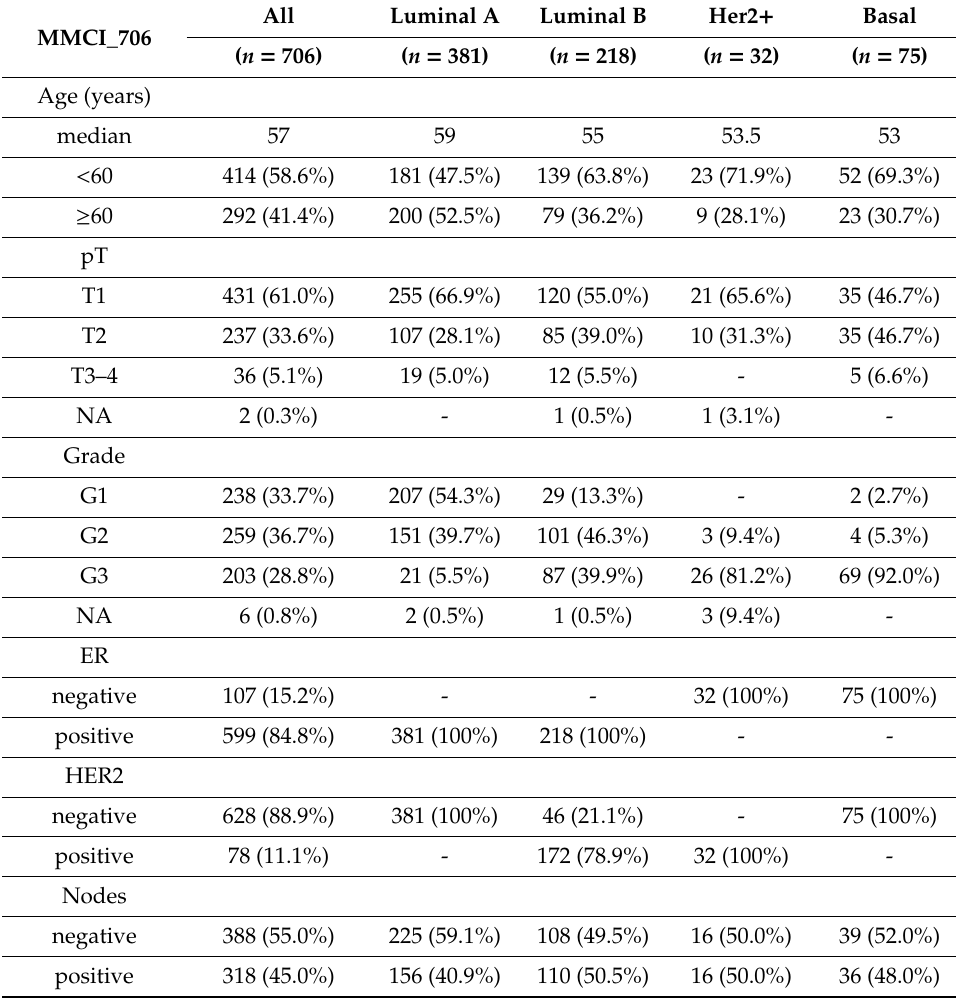
Table 4. Patient characteristics in MMCI_706 set of